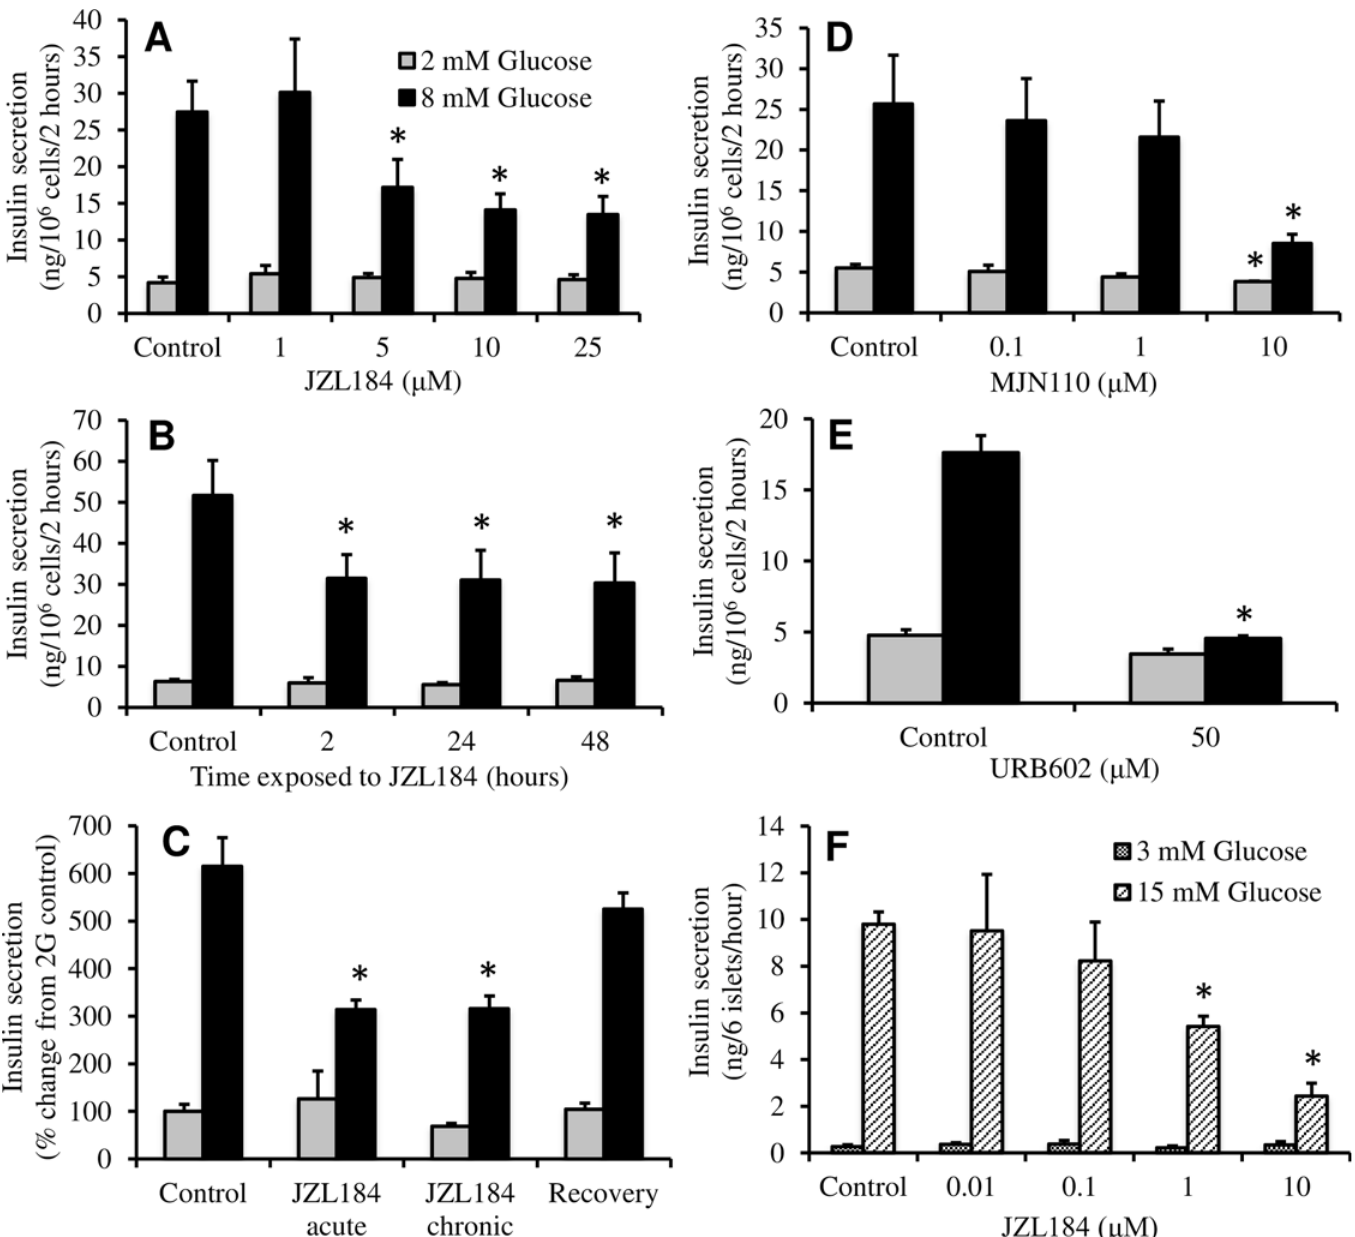
Fig 1. Inhibition of MGL reduced GSIS in INS-1 cells and isolated rat islets. (A) JZL184 dose-dependently reduced GSIS during static incubations in INS-1 cells (n = 3). (B) JZL184 (10 μ M) reduced GSIS in INS-1 cells regardless of the temporal exposure (n = 3). (C) INS-1 cells demonstrated a partial recovery of GSIS following the removal of JZL184 (10 μ M) for 2 hours (n = 3). (D) MJN110 dose-dependently reduced GSIS during static incubations in INS-1 cells (n = 4). (E) URB602 (50 μ M) inhibited GSIS during static incubation in INS-1 cells (n = 3). (F) JZL184 dose-dependently reduced GSIS in isolated whole rat islets during a static incubation (n = 3). Error bars represent S.E. from independent experiments ( * , p <